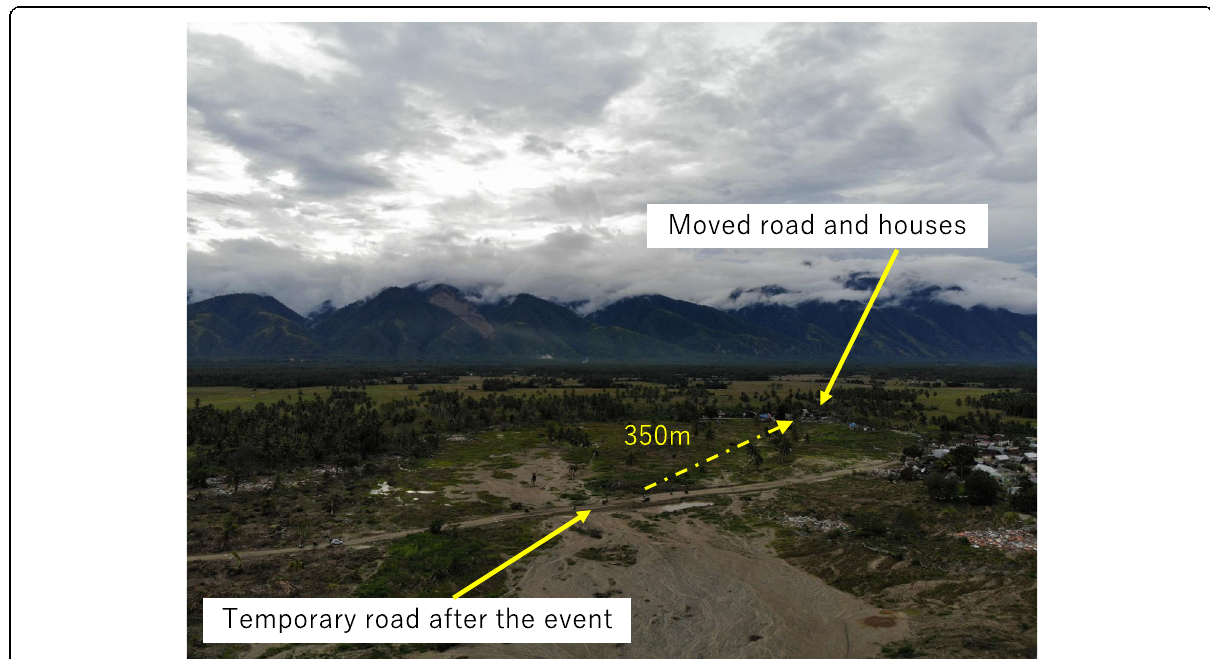
Fig. 13 Photo of Sibalaya village taken by a drone after Earthquake